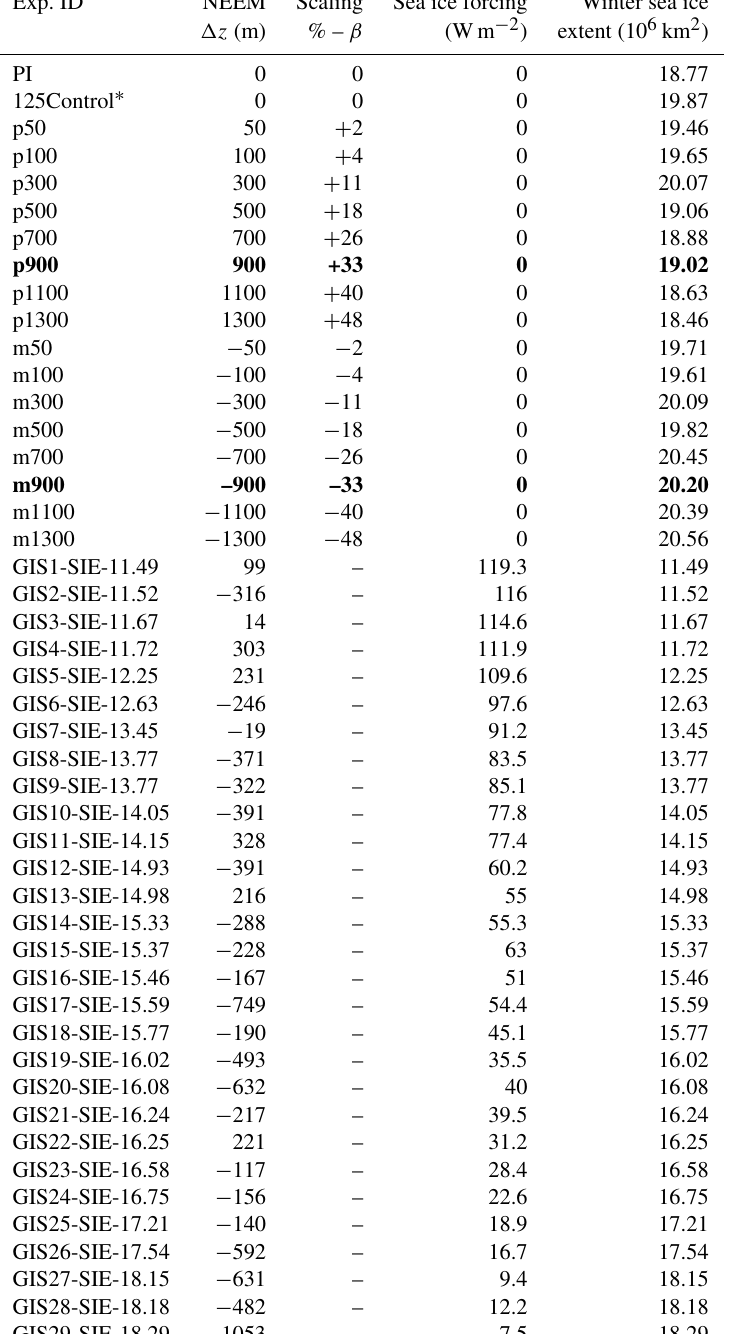
Table A1. Full list of scenarios. The simulations highlighted in bold font are the ones primarily discussed in the text. All LIG simulations are performed with greenhouse-gas and orbital forcing centred at 125ka (eccentricity – 0.04001; obliquity – 23.80 ◦ ; perihelion – 201.3d of the year; CO 2 – 276ppmv; CH 4 – 640ppbv; N 2 O – 263ppbv). The boundary conditions for the PI simulation are the following: